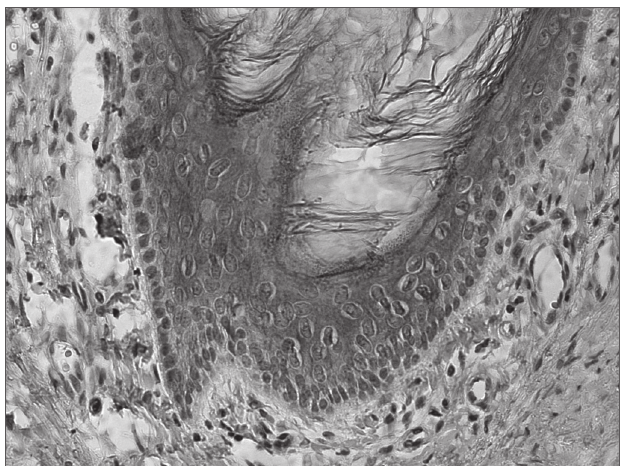
Figura 1. Expressão de CK 16 nas camadas suprabasais no epitélio